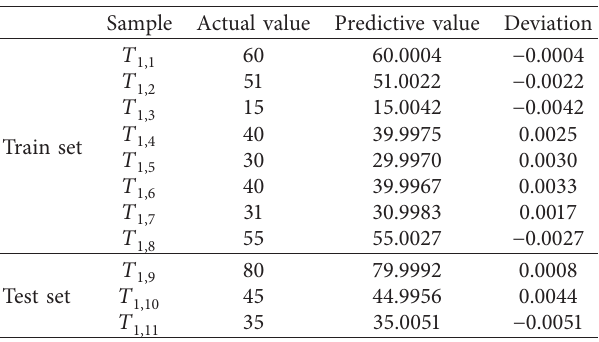
Table 5: The train and test result of the 11 similar tasks.